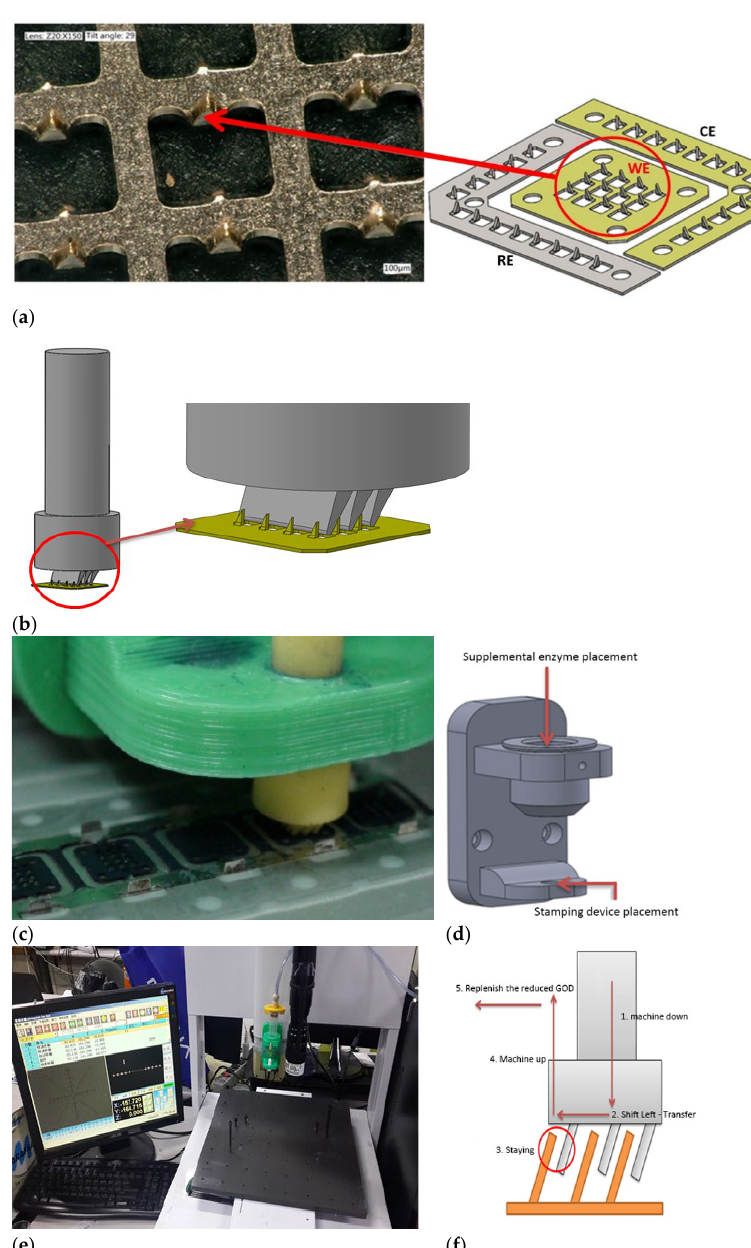
Figure 3. ( a ) Structure of microneedle array sensor; ( b ) schematic diagram of the stamping device and glucose oxidase transfer; ( c , d ) stamping device and fixture for the stamping device; all molds are printed on 3D printers at 200 °C and 50 mm/s. ( e ) The Lixi Technology’s 3-axis automatic dis- pensing machine with molds ( f ) the steps of the transfer process.